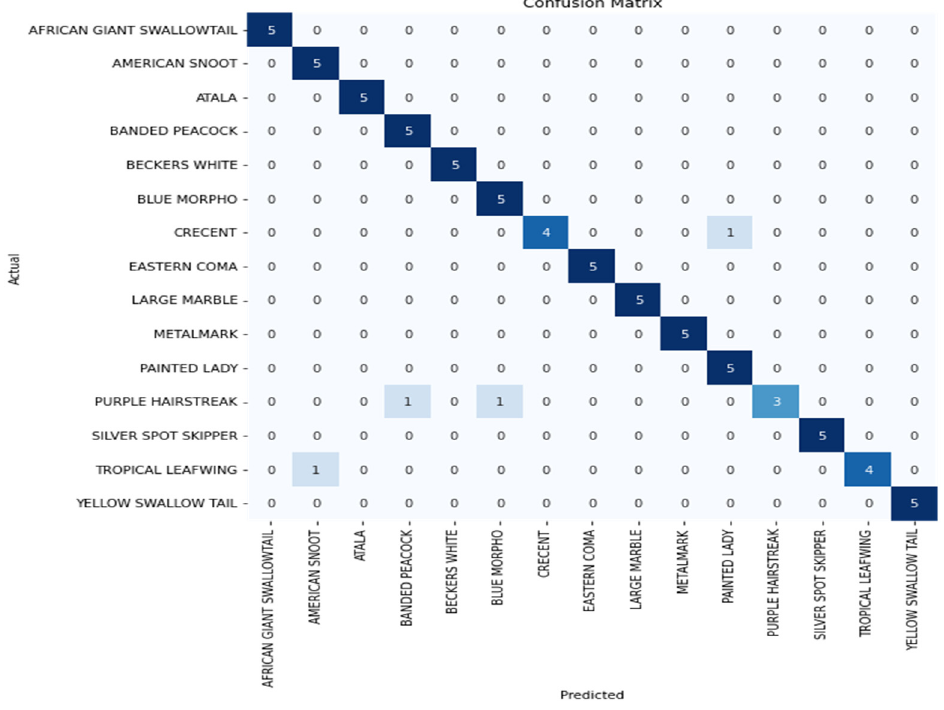
Figure 4. Confusion Matrix for InceptionV3.